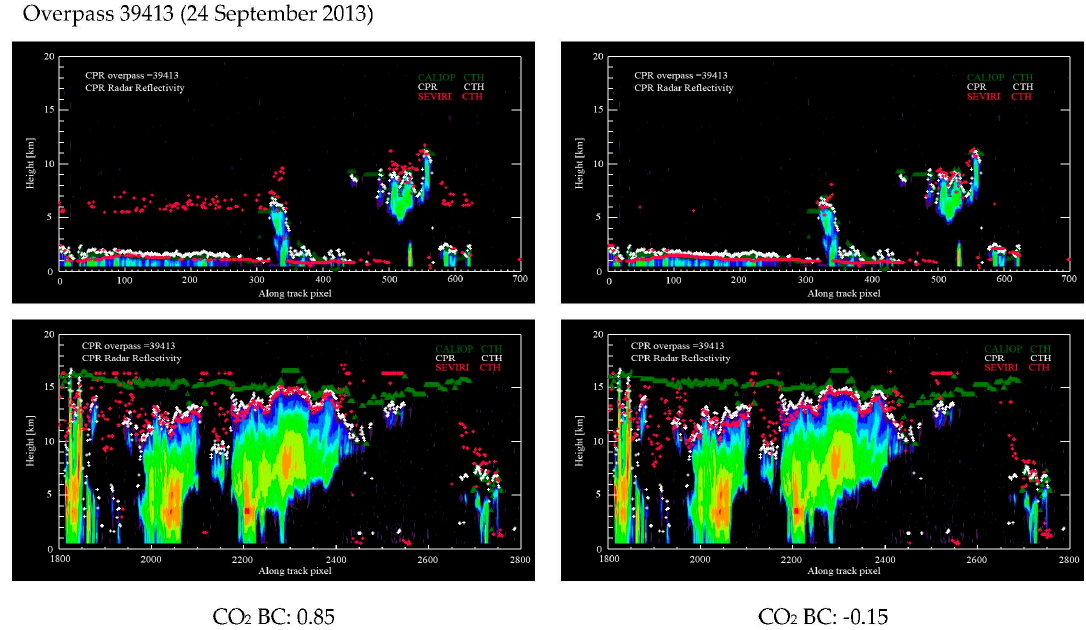
Figure 6. Comparison of Spinning Enhanced Visible and Infrared Imager (SEVIRI) cloud-top heights (CTHs) derived by using different CO 2 bias correction increment (BC) values. The left-panels show the results derived by using the CO 2 BC values prior to the update, and the right-hand panel shows the CTH derived afterward for CPR (Cloud Profiling Radar) overpass 39,413 on 24 September 2013. CTHs from Cloud-Aerosol LiDAR with Orthogonal Polarization (CALIOP), CPR, and SEVIRI are plotted as dark green triangles and white and red crosses, respectively.